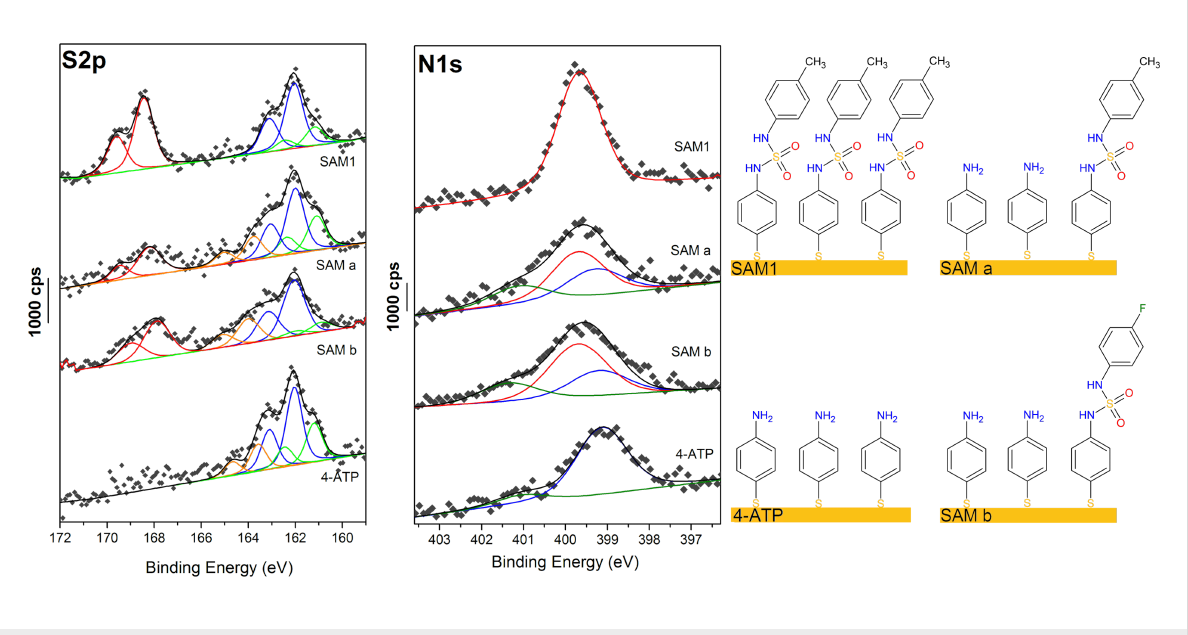
Figure 3: High resolution S2p and N1s XPS spectra of the 4-ATP SAM, the 4-ATP SAM after reaction with 4-FC 6 H 4 SO 2 NHOSO 2 -4-FC 6 H 4 (SAM b) or TsNHOTs (SAM a) and the sulfamide 1 SAM (SAM 1). Right panel: Schematic view of the different SAMs created on gold surfaces.